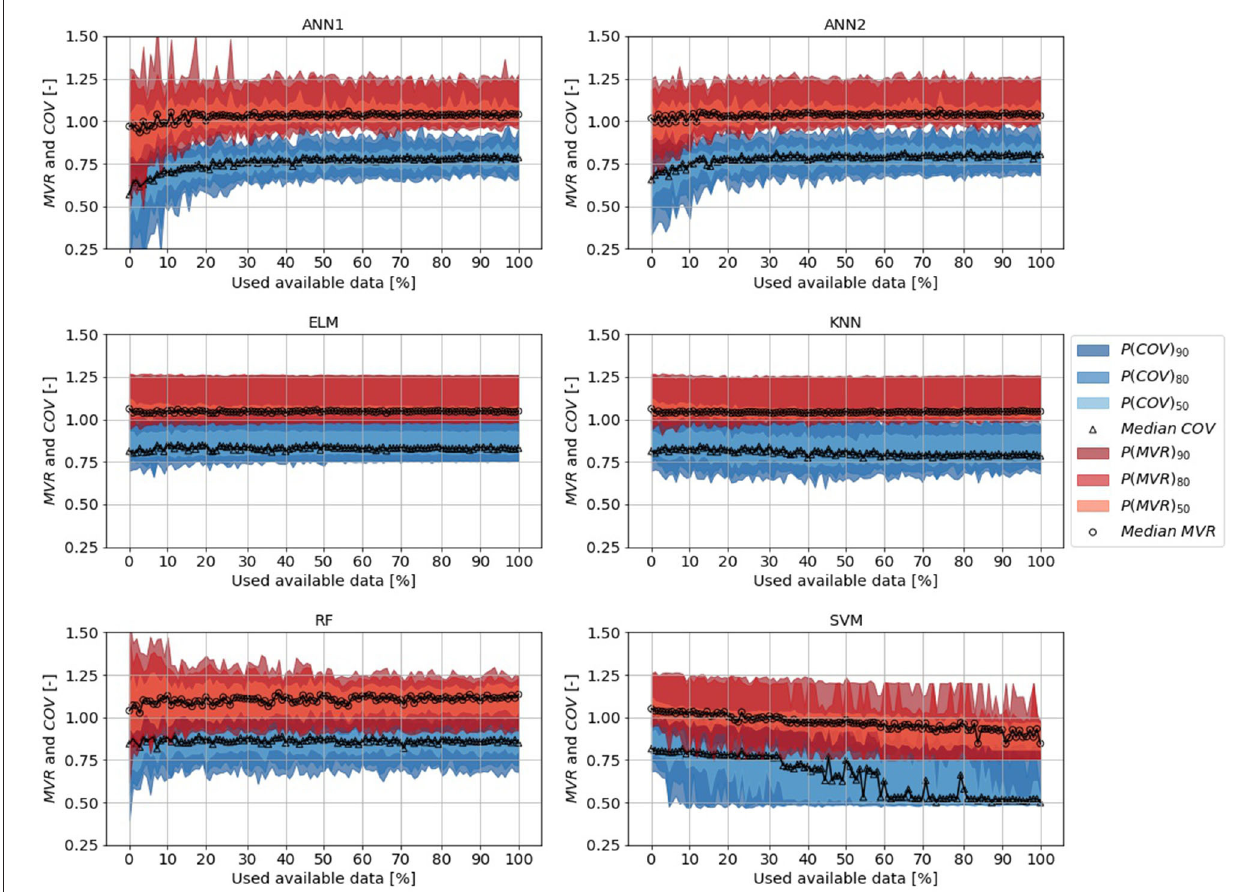
FIGURE 9 | Dependence of mean volume reproduction (MVR)/temporal coverage (COV) and size of the training data set for different ML-algorithms in regional application. Uncertainty belts with different probabilities (50, 80, 90%) drawn for MVR in red scales, for COV in blue scales. The amount of training data has been raised incrementally to train the algorithms. Validation was performed on data sets in regional neighborhood of the training data sources in the Main